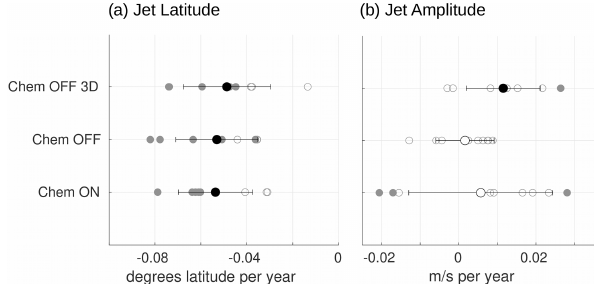
Figure 10. The 1969–1998 DJF trend for the 850hPa (a) jet lati- tude (in degrees latitude per year) and (b) jet amplitude (in meters per second per year) in the different model experiments. Single en- semble members are shown in gray; the ensemble mean is shown in black including an error bar for 1 standard deviation. Filled circles show a statistically significant trend at the 95% level based on a Mann–Kendall